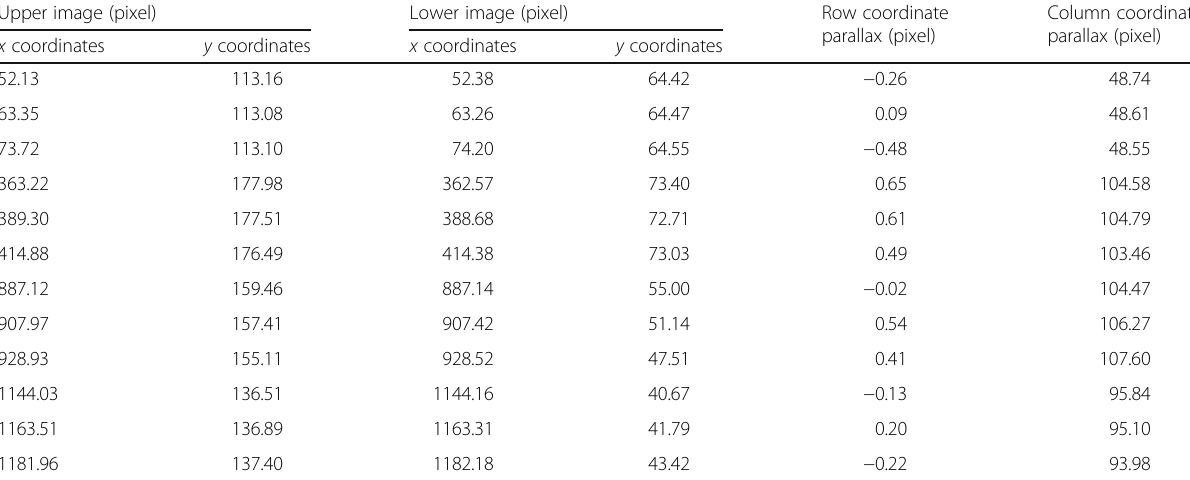
Table 5 Stereo rectification accuracy